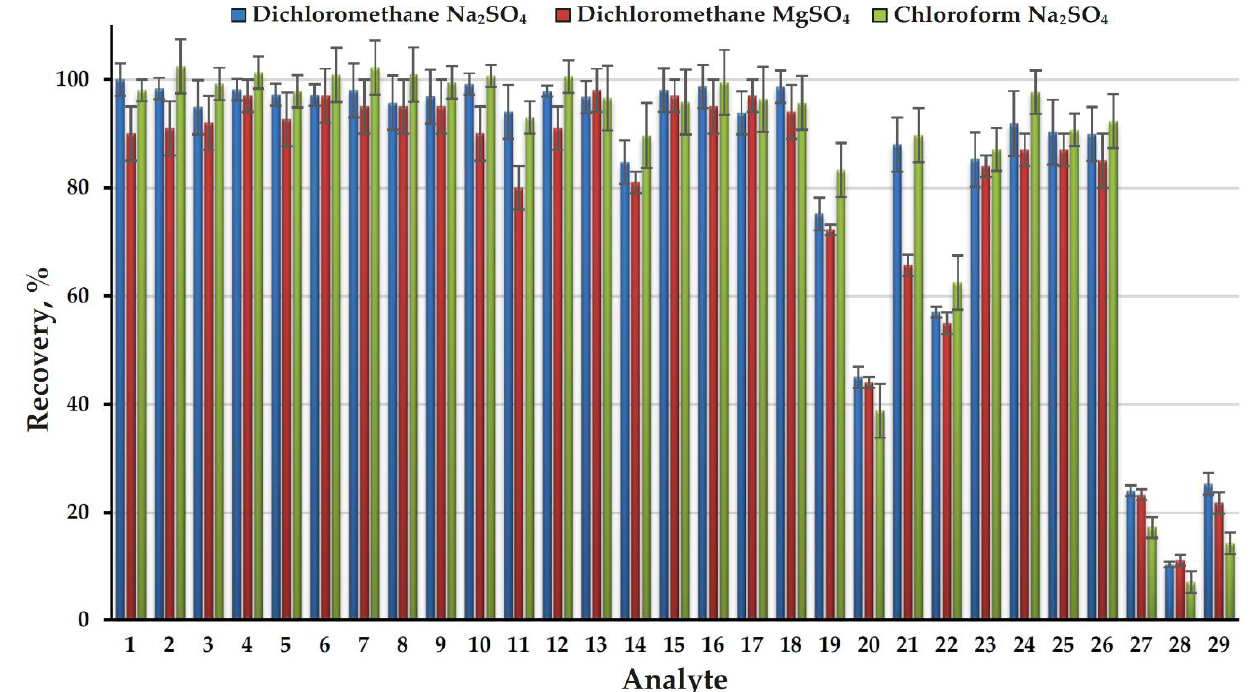
Figure 2 . Recoveries of analytes (extraction efficiency) obtained with three extractant-dehydrating agent systems .